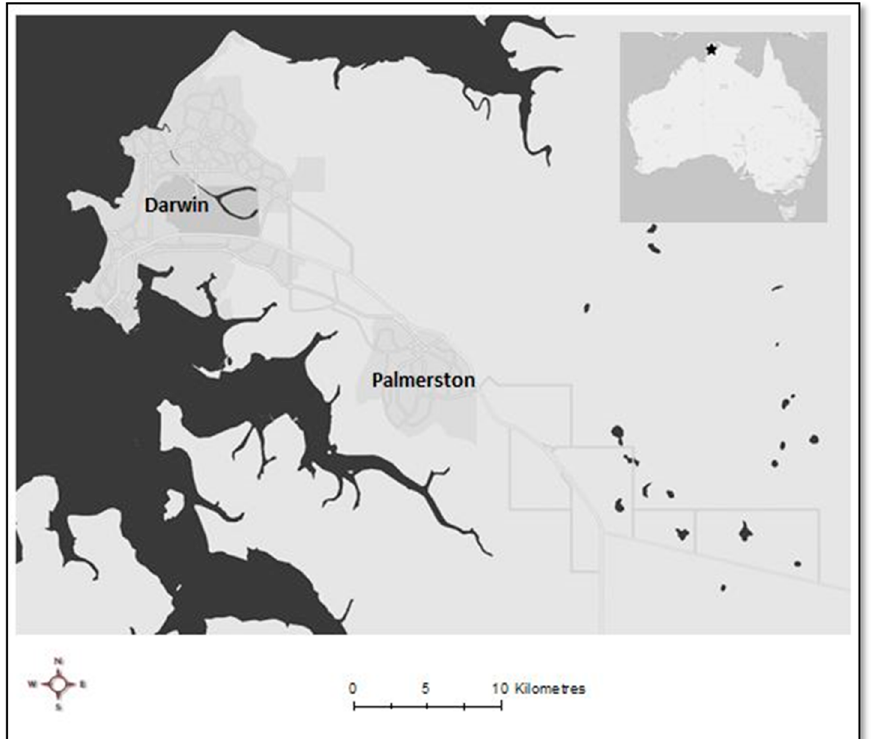
Figure 1. Study area of the Greater Darwin region (map data sources: Esri, DeLorme, HERE, USGS, Intermap, iPC, NRCAN, Esri Japan, METI, Esri China (Hong Kong), Esri (Thailand), MapmyIndia, Tomtom).